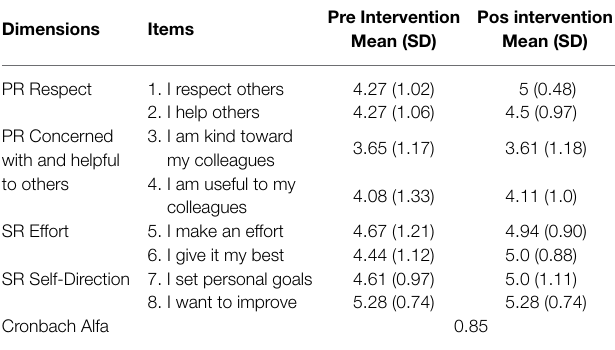
TABLE 2 | Dimensions, description and items concerning the Portuguese version of the personal and social responsibility (Martins et al., 2015). Dimension Description Items